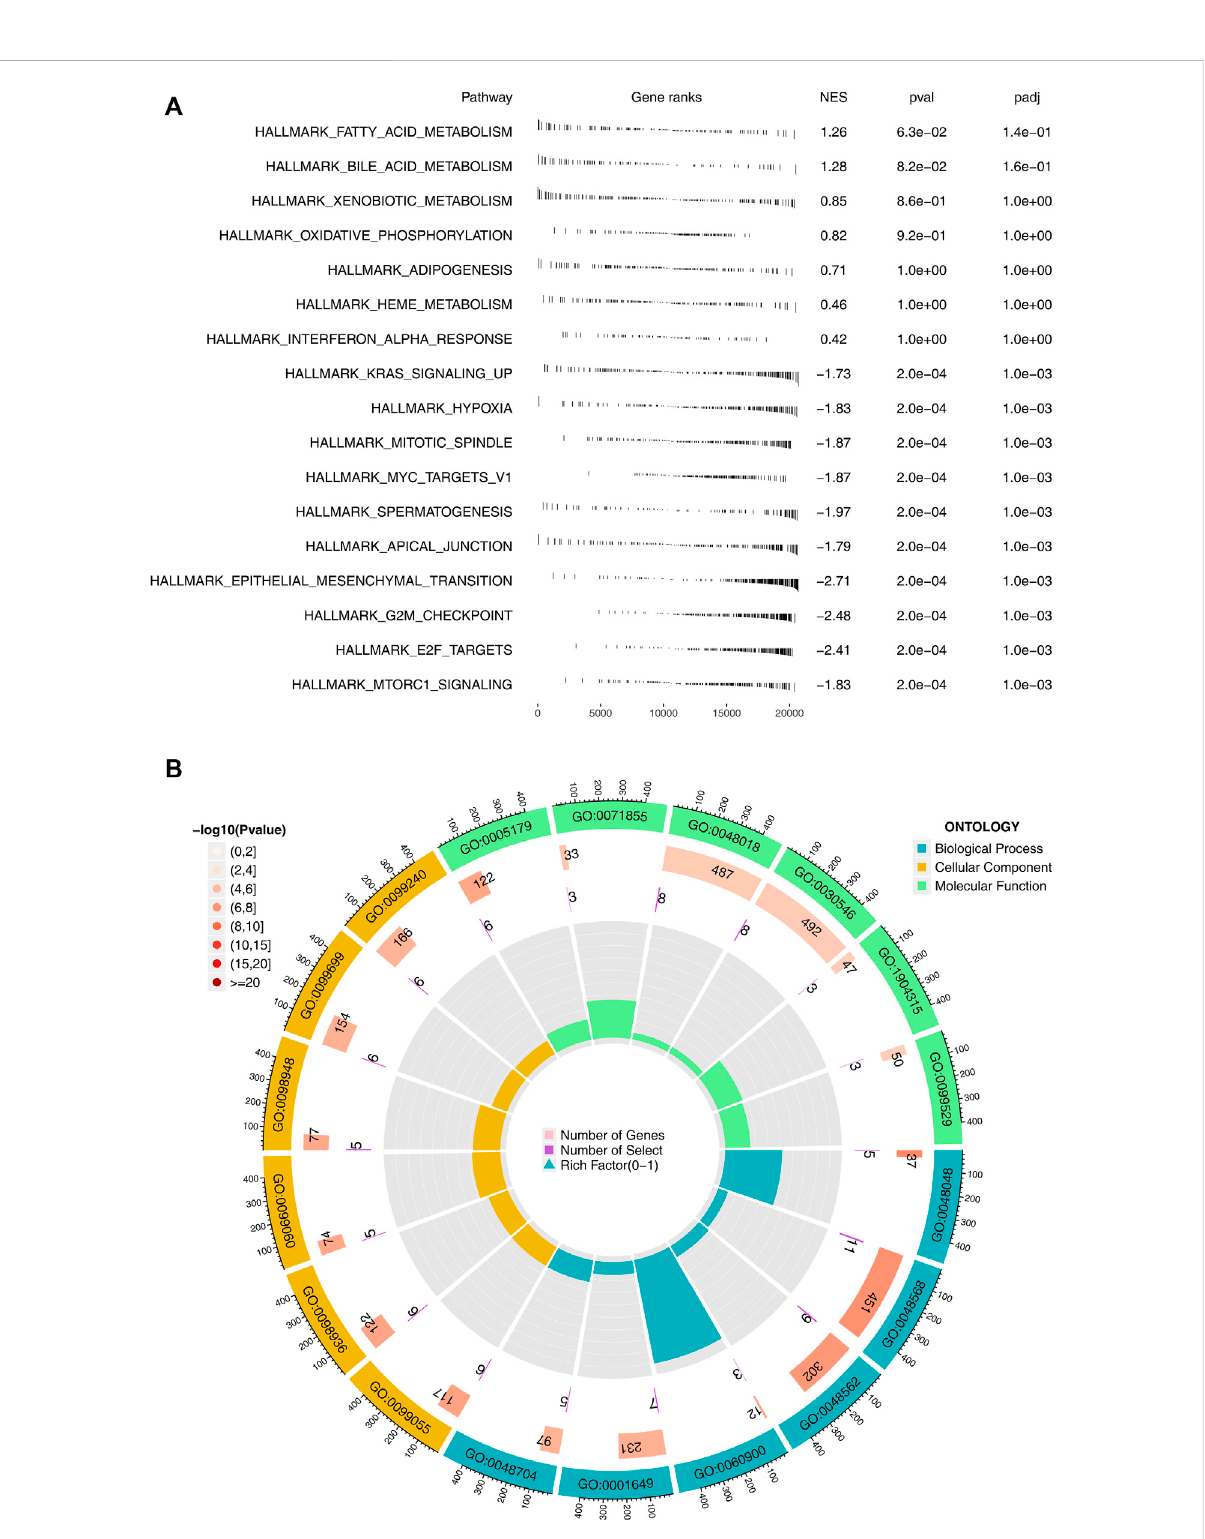
FIGURE 4 Biological enrichment analysis. Notes: (A) GSEA analysis between high and low logistics score based on the Hallmark gene set; (B) GO analysis between high and low logistics